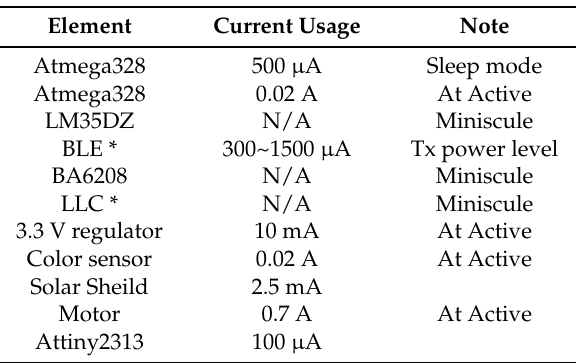
Table 1. Current consumption of each component of the sensor system.